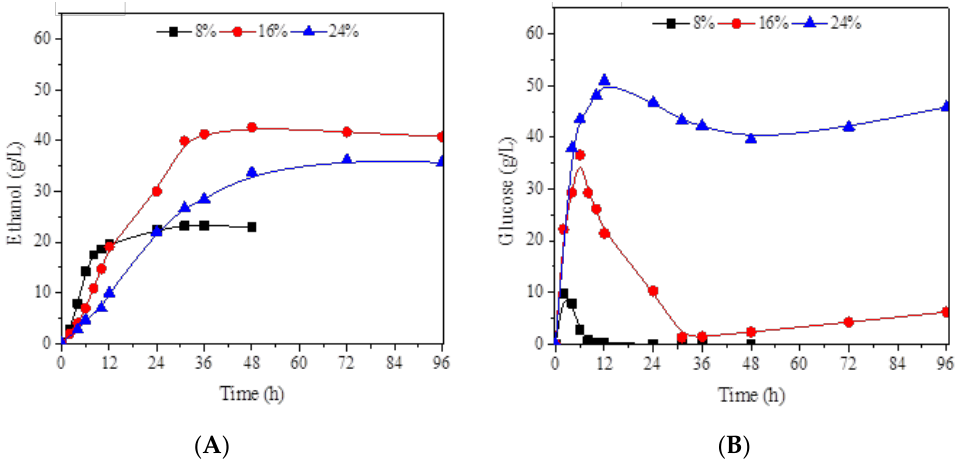
Figure 3. Effect of the solid loading during batch SSF of pre-treated rice straw in the VBM reactor under optimized conditions (18 spheres, 41.5 °C) at 200 rpm. Ethanol production ( A ) and glucose consumption ( B ). Standard deviations were lower than 10%.